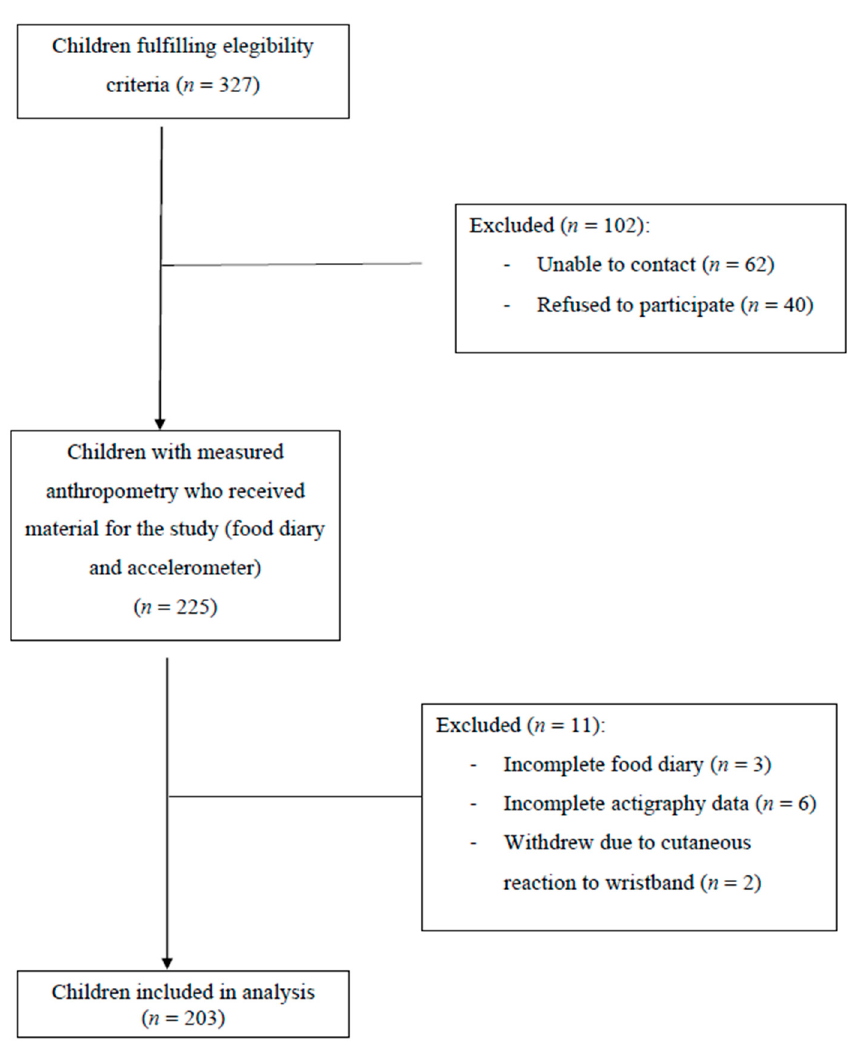
Figure 1. Flow Figure 1. Flow diagram.